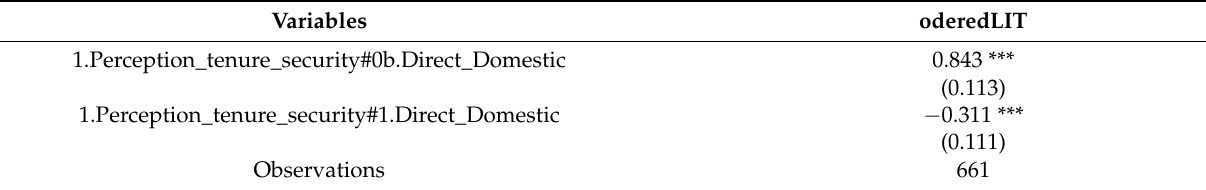
Table 10. Effect of direct exposure to LSLA by domestic entities through tenure